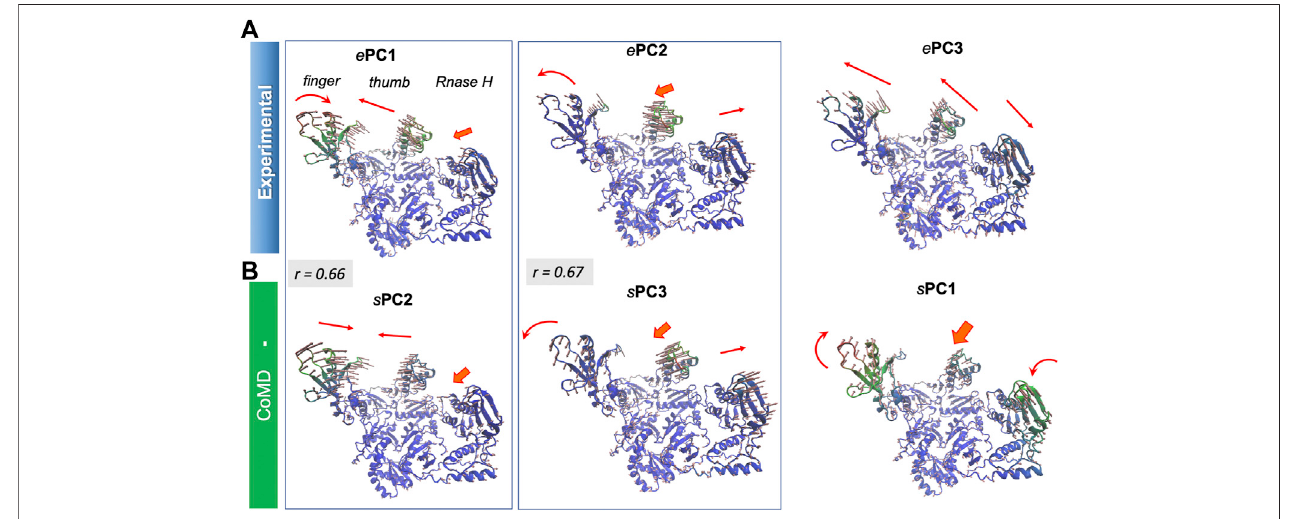
FIGURE9| FirstthreeprincipalmodesforHIV-1RTensembles.The (A,B) arebasedonPCAofexperimental andcoMDensembles,respectively.Pairsthatexhibit relatively high ( > 0.65) correlations are enclosed in boxes. See the corresponding Supplementary Movie S4 .